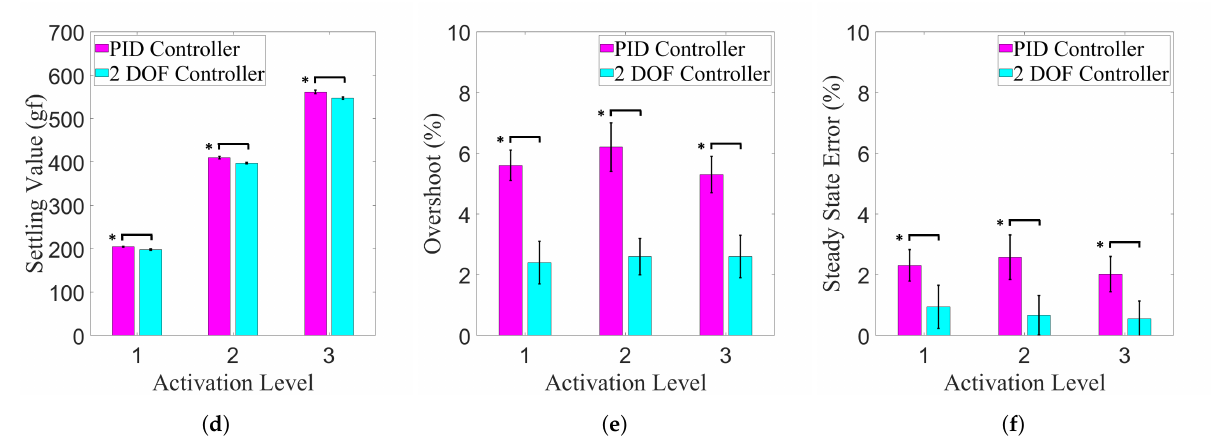
Figure 20. Calculated control performance values for the PID and 2 DOF controller implementation experiments, compared to activation level. A ∗ denotes a grouping with a significant difference. All p values < 0.01. ( a ) Time constant values. ( b ) Rise time values. ( c ) First peak time values. ( d ) Settling values. ( e ) Percent overshoot values. ( f ) Percent steady state error